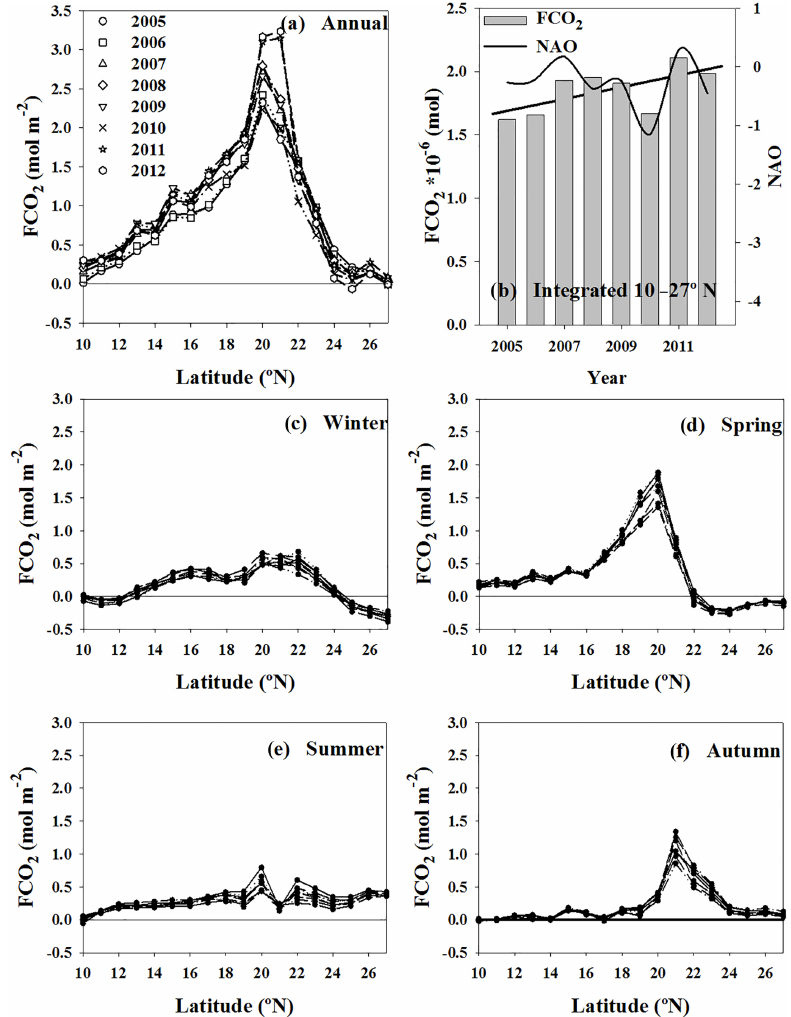
Figure 7. Latitudinal distributions of seasonal and annual CO 2 fluxes (FCO 2 , molm − 2 ) . Fluxes of CO 2 were computed using Nightingale et al. (2000) parameterization and satellite winds with a resolution of 6h. (a) Integrated year to year from 2005 to 2012 and (b) latitudinally integrated for 2005 to 2012 together with annual values for the North Atlantic Oscillation (NAO) index. Latitudinal distributions of FCO 2 seasonally integrated from 2005 to 2012 are depicted for (c) winter (December, January, and February), (d) spring (March, April, and May), and (e) summer (June, July, and